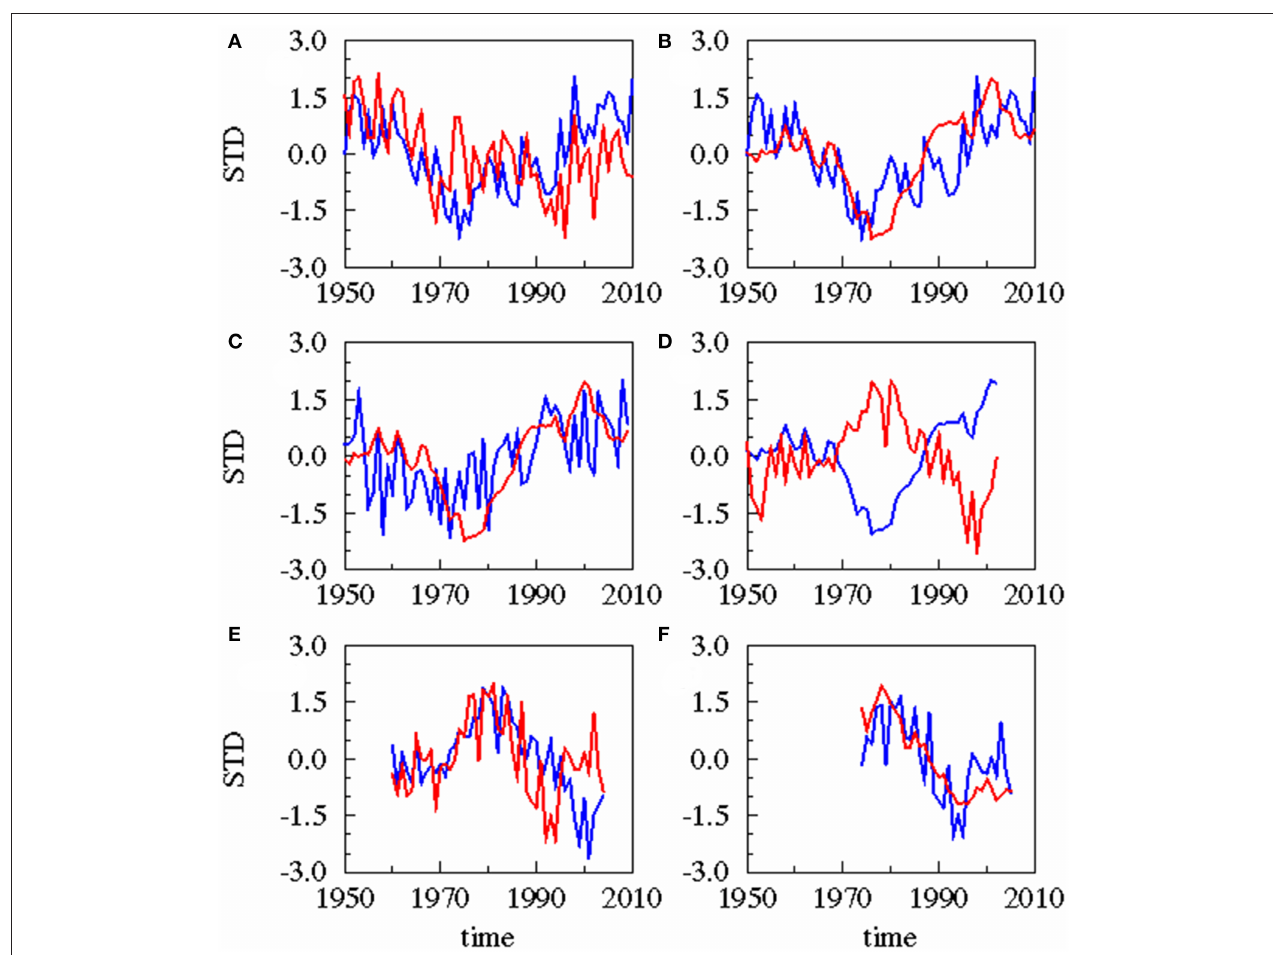
FIGURE 4 | Results of statistical downscaling experiment: Principle Component of the 1st Canonical Correlation Analysis (CCA) patterns of predictor (blue) and predictand (red). All experiments are based on annual averaged time series. Different time lags exist for these combinations. (A) AMO (blue), precipitation (red), lag = 0 year; (B) AMO (blue), cumulative river runoff (red), lag = − 2 years; (C) precipitation (blue), cumulative river runoff (red), lag = − 1 year; (D) cumulative river runoff (blue), salinity (red), lag = − 3 years; (E) salinity (blue), zooplankton spring biomass of P. acuspes (red), lag = − 1 year; (F) zooplankton (blue) herring weight (red), lag = − 3 years. Lag, correlation, skill, and significance are also given in Table 1 .